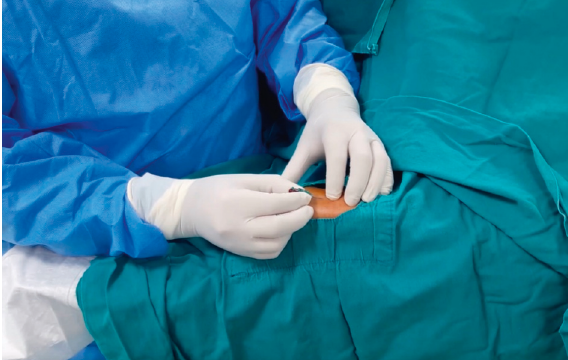
Figure 1: Palpation and puncture of the distal radial artery.